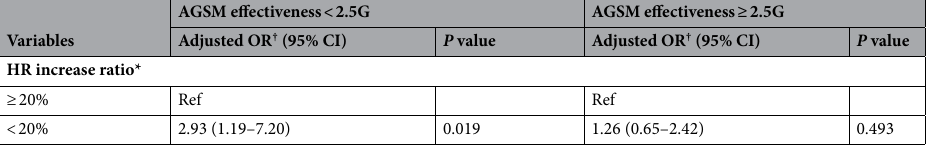
Table 5. Combined effect of HR increases and AGSM effectiveness. HR heart rate, BMI body mass index, AGSM anti-G straining manoeuvre, OR odds ratio, CI confidence interval. † Model adjusted for age, BMI. *Maximal HR during the initial 1–5 s of the 9G profile divided by HR before 9G